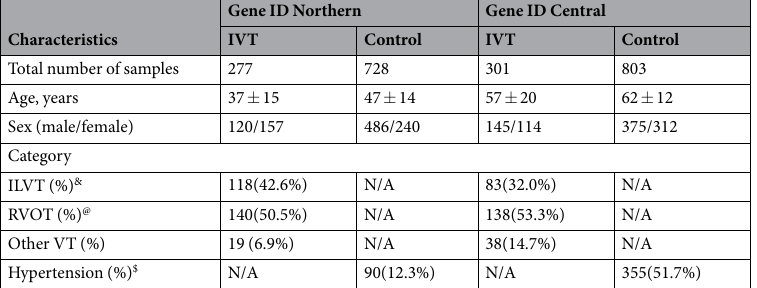
Table 1. Clinical characteristics of the study population. Data are shown as the means ± SD for quantitative variables and as n (%) for qualitative variables. * Age at first diagnosis of the disease. & ILVT: idiopathic left ventricular tachycardia. @ RVOT: right ventricular outflow tract tachycardia. $ Hypertension was defined as a systolic blood pressure of > 140 mmHg or a diastolic blood pressure of > 90